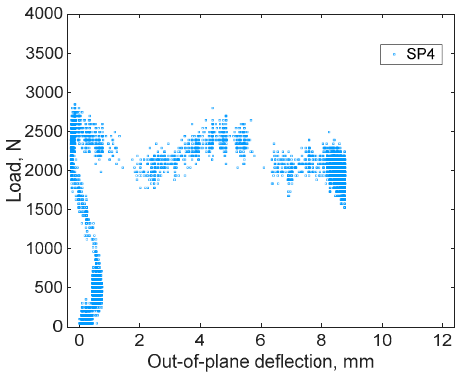
Figure 8. Out-of-plane displacement of Wall 2.